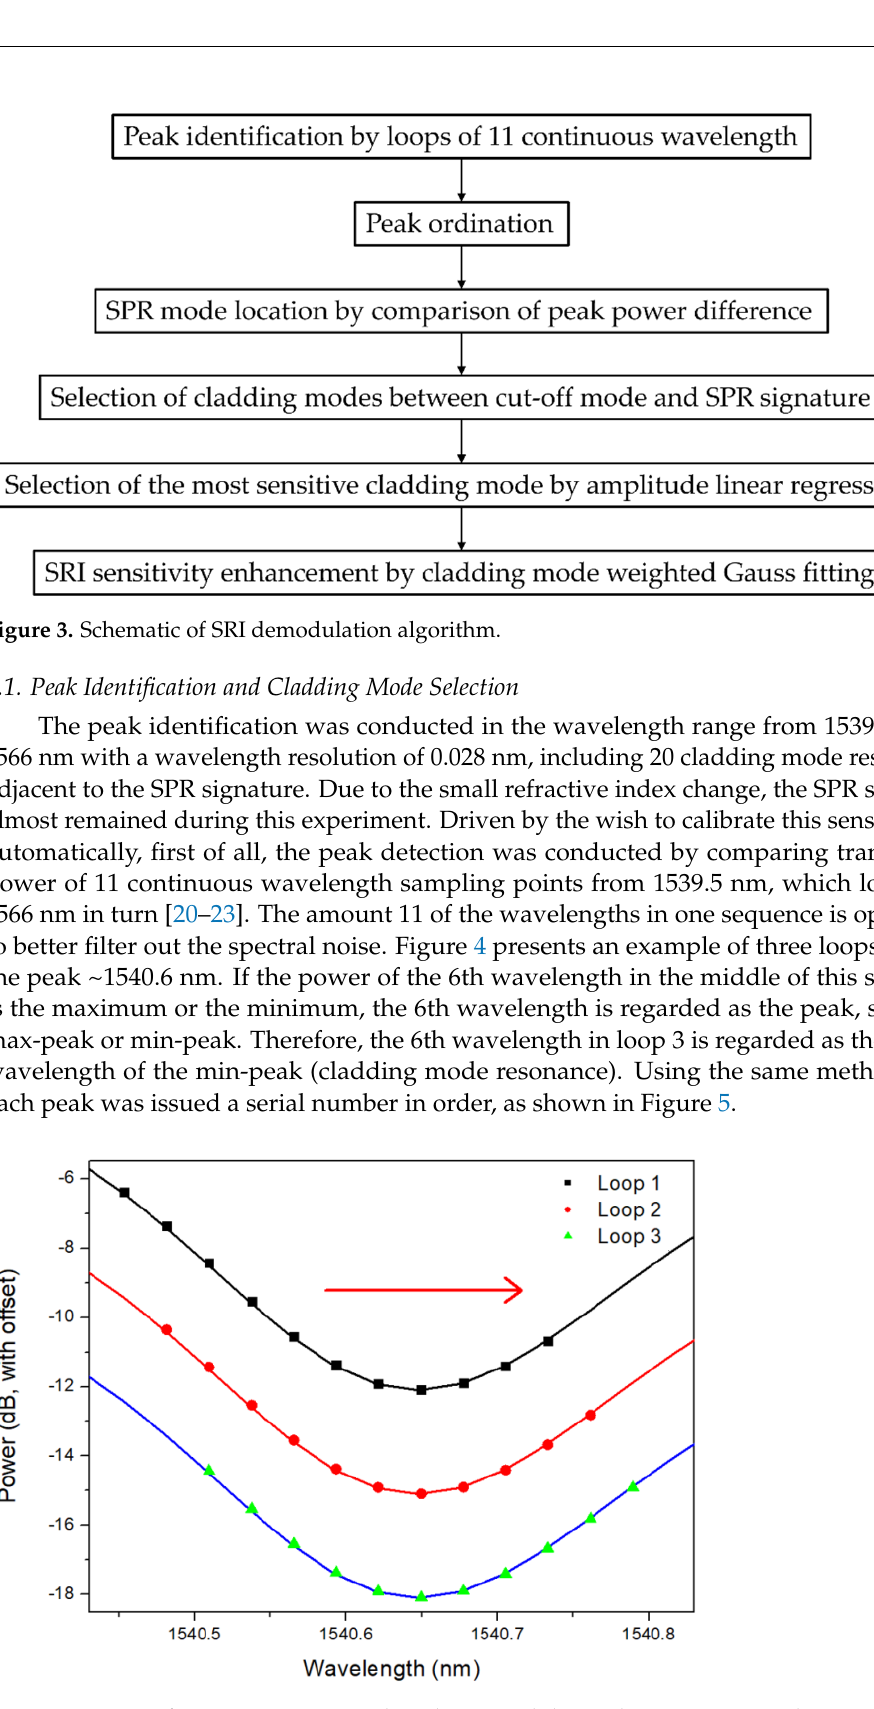
Figure 4. Loops of 11 continuous wavelengths around the peak ~1540.6 nm in the initial glucose aqueous solution with a SRI of ~1.3573.